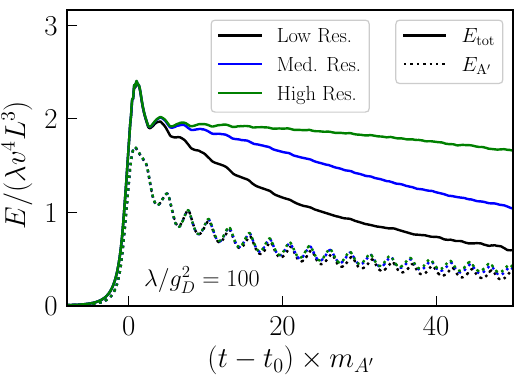
Figure 18 . The total energy (solid lines) and vector field energy (dashed lines) as a function of time for λ/g 2 = 100 , and three different numerical D